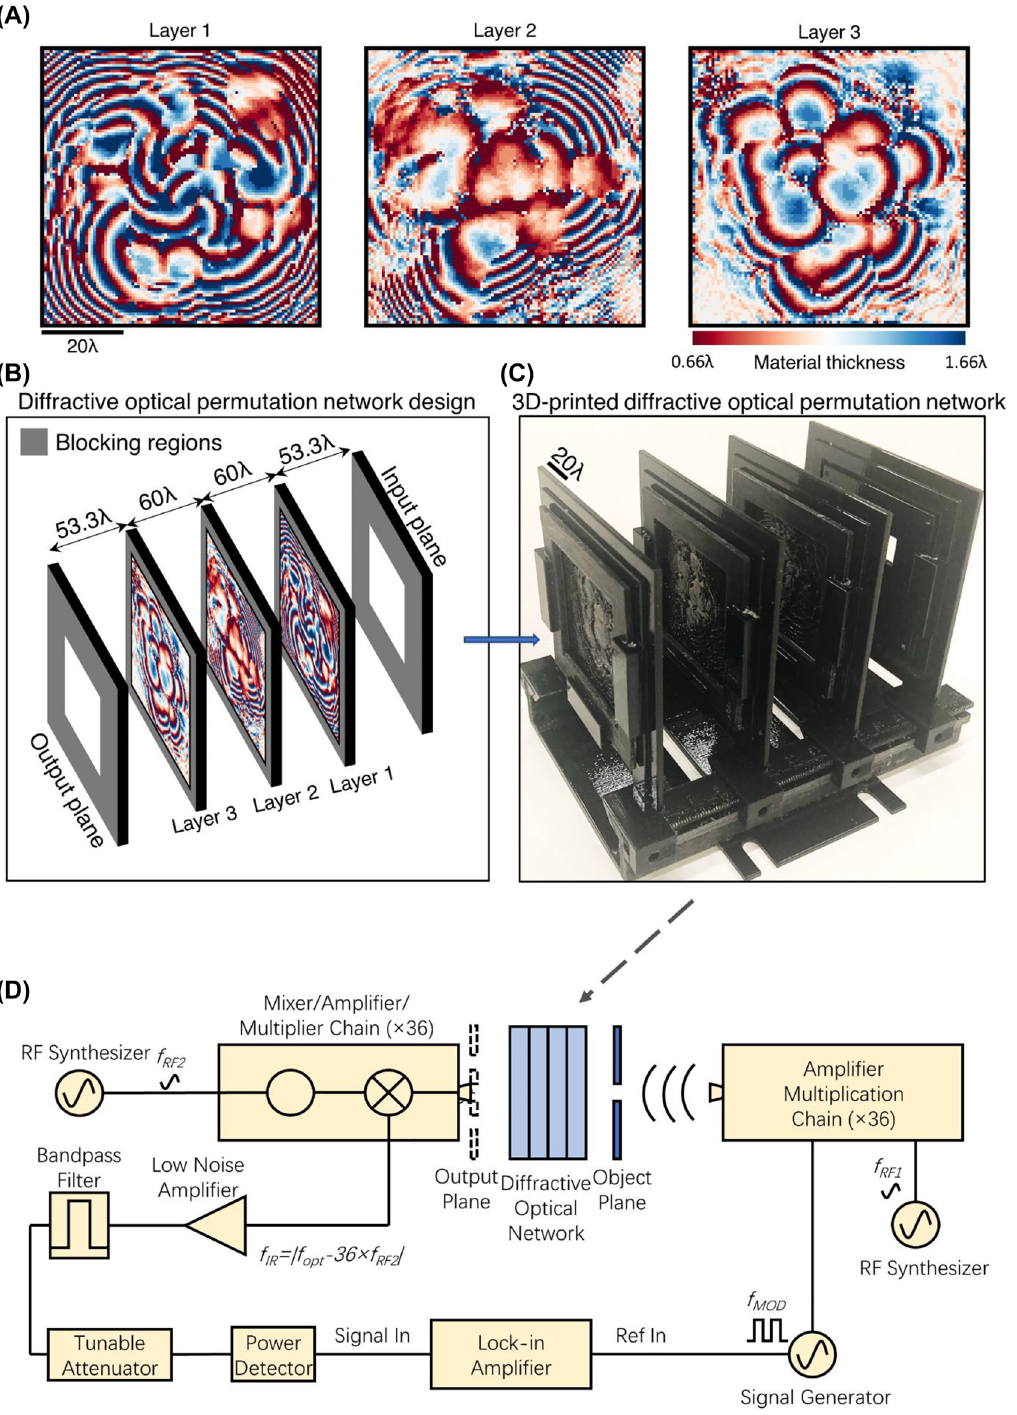
Figure 5: Experimental demonstration of a diffractive permutation network. (A) The material thickness profiles of the diffractive surfaces of the fabricated diffractive permutation network. (B) The schematic of the experimental architecture illustrating the forward optical model of the diffractive permutation network. (C) 3D printed diffractive permutation network operating at THz part of the spectrum. (D) The schematic of our experimental